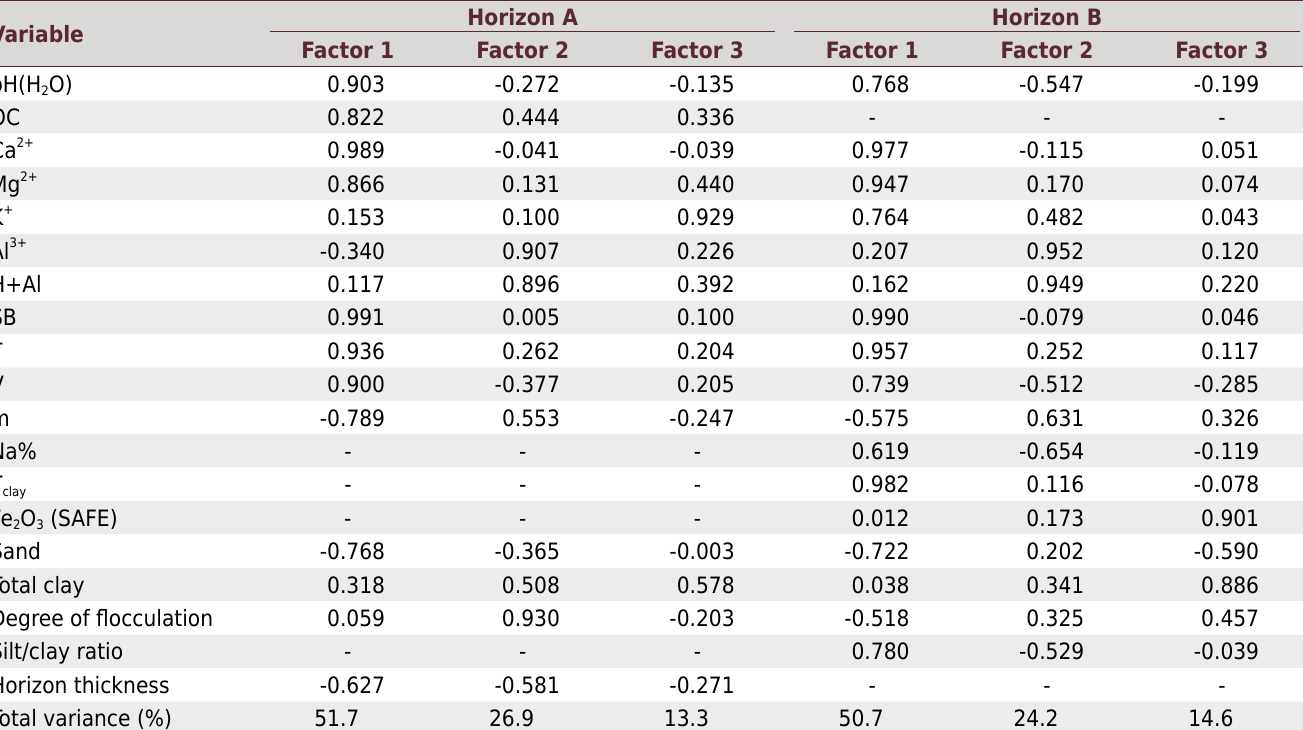
Table 5. Factorial loads of chemical and physical variables in the first three axes in horizons A and B of the soil studied